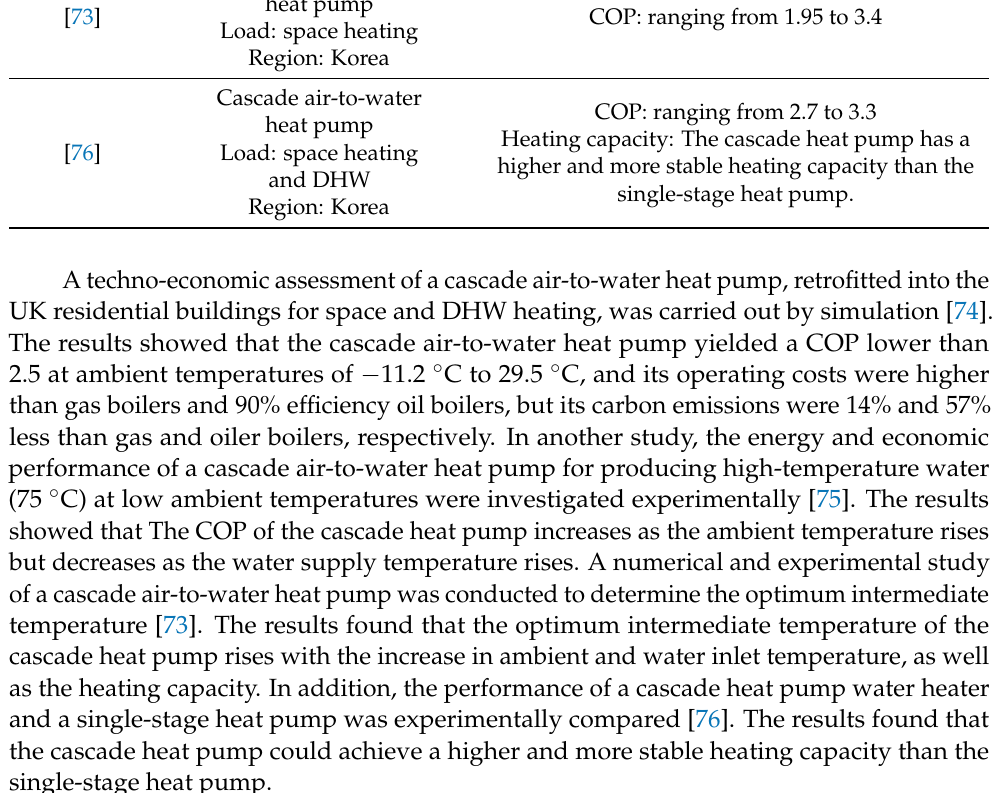
Figure 14. Schematic of the cascade air-to-water heat pump system.